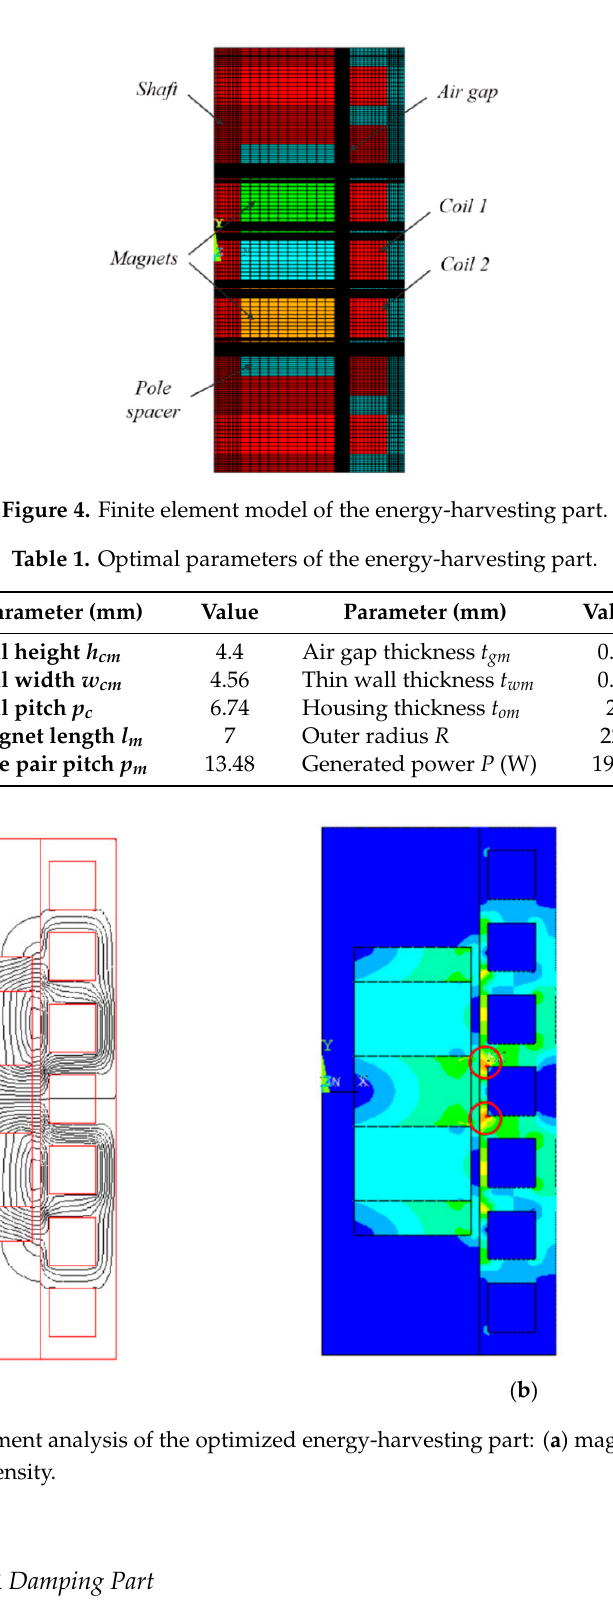
Figure 5. Finite element analysis of the optimized energy-harvesting part: ( a ) magnetic flux lines and ( b ) magnetic flux density.